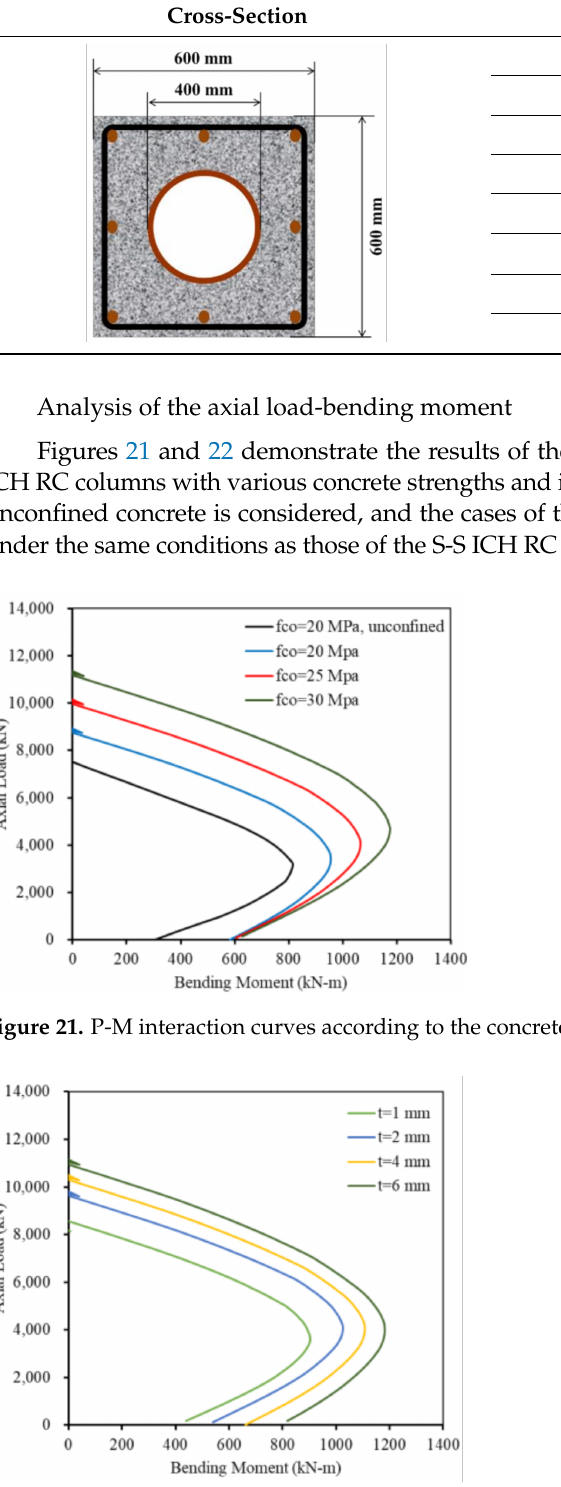
Figure 22. P-M interaction curves according to the inner tube thickness (S-C